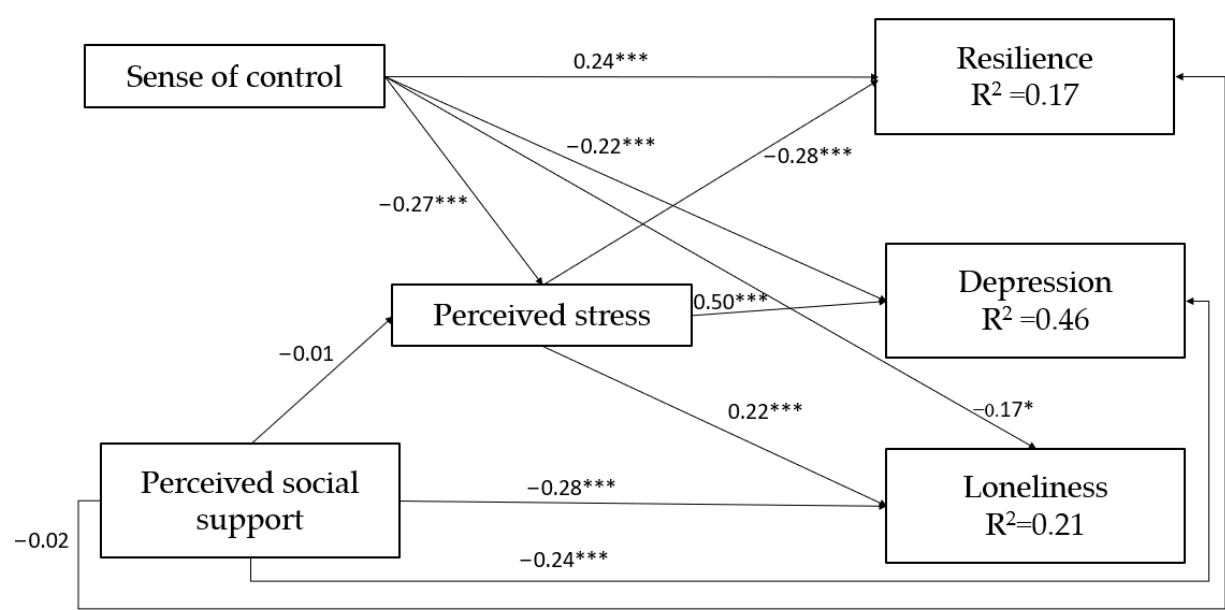
Figure 1. The study model. Note: All independent and mediating parameters are standardized. * p < 0.01, *** p < 0.001.